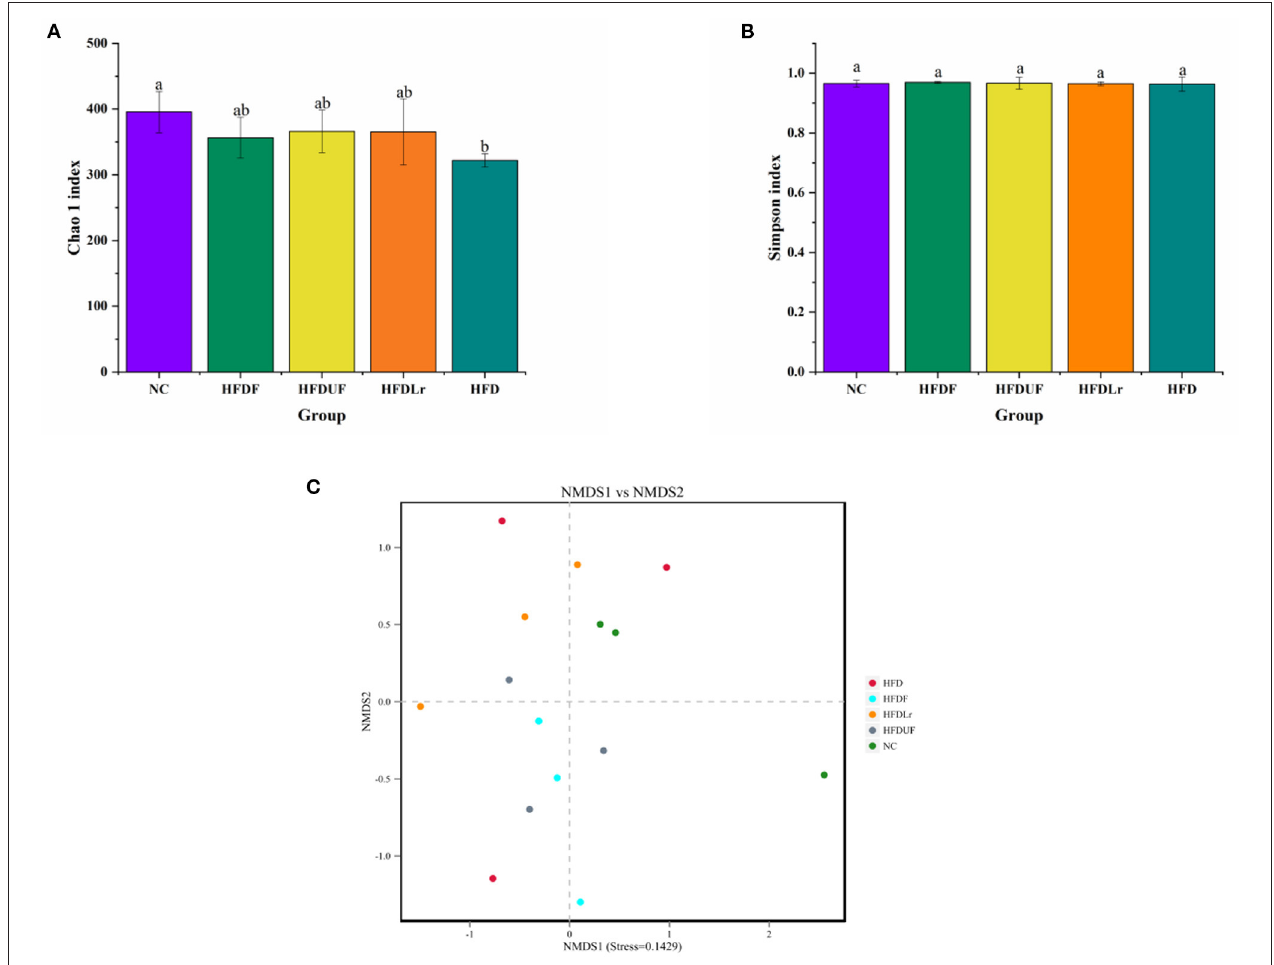
FIGURE 7 | The effects of CSM on the diversity of intestinal microbiota in the HFD-fed mice. (A) Chao 1 index and (B) Simpson index to determine the alpha diversity of each sample group. (C) Non-metric multidimensional scaling (NMDS) for beta diversity analysis of each sample group. The superscript letters indicate significant differences between